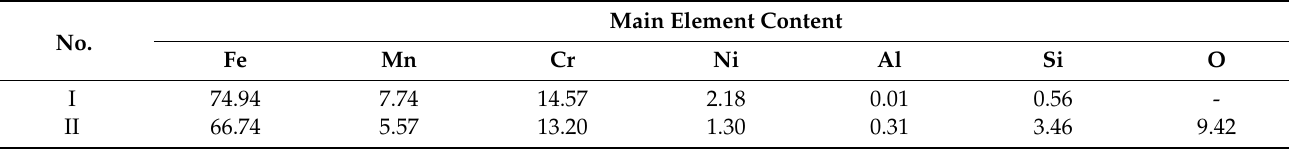
Table 9. The results of EDS in different areas (wt. %). Main Element